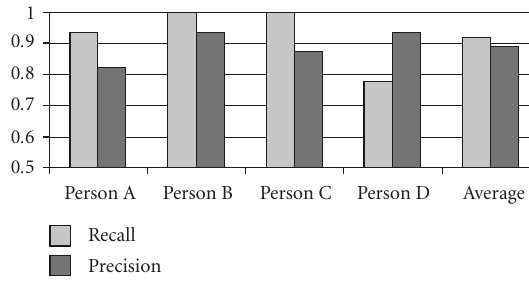
Figure 5: Precision and recall for motion cluster detection in “BroadGym” sequences.